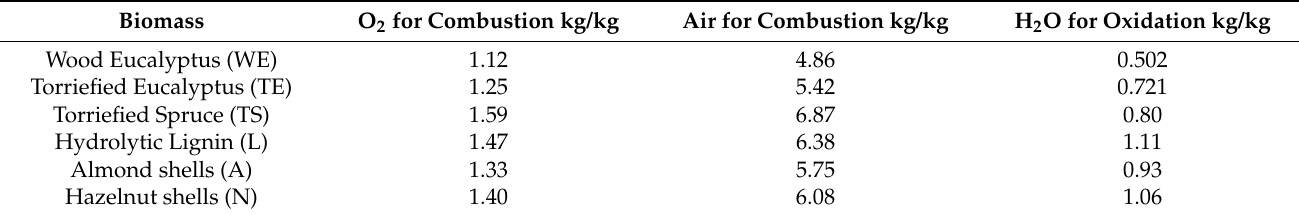
Table 4. Gasification properties of residues